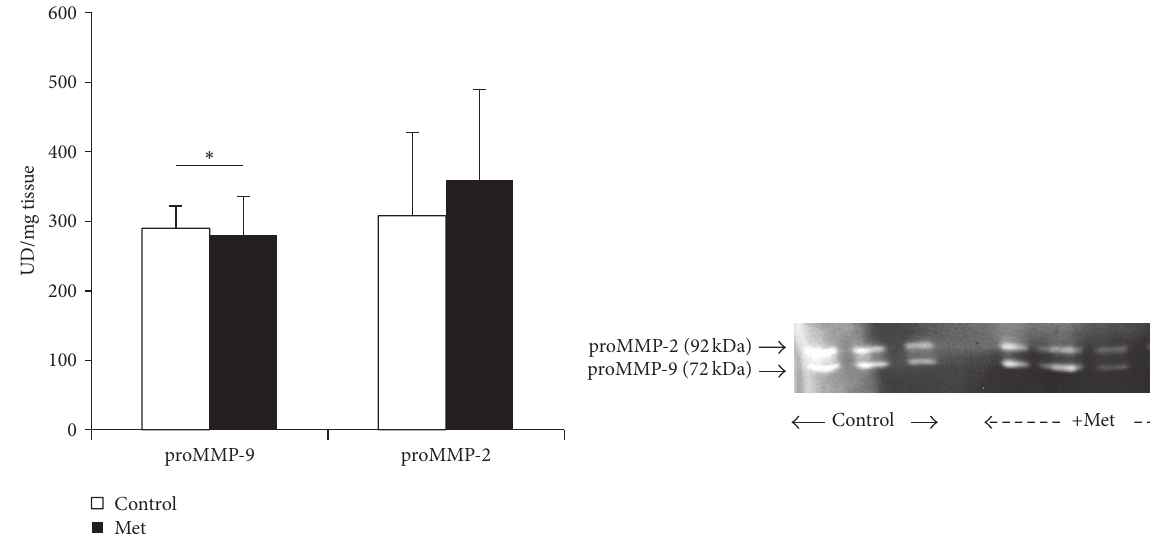
Figure 12: Aorta MMP activities of rabbit offspring. Control: offspring from control female rabbit (PC); Met: offspring from female rabbit fed Met enriched diet (PMet). ( ∗ 𝑝 < 0.05